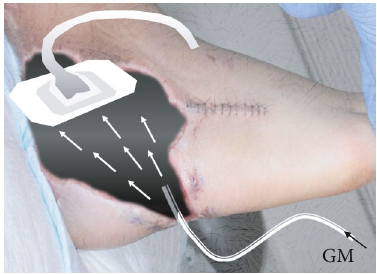
Figure 6: Schema of continuous local antibiotics perfusion circuits adapted to case #1. GM: gentamicin.